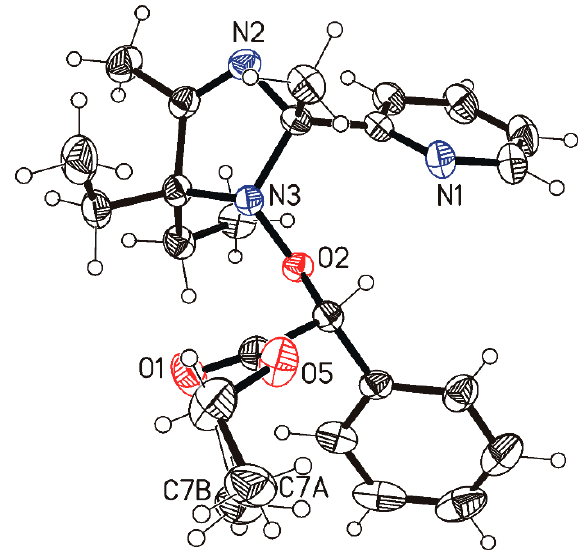
Figure 10. XRD structure of 2 RS/SR . (Displacement ellipsoids are drawn at the 30% probability